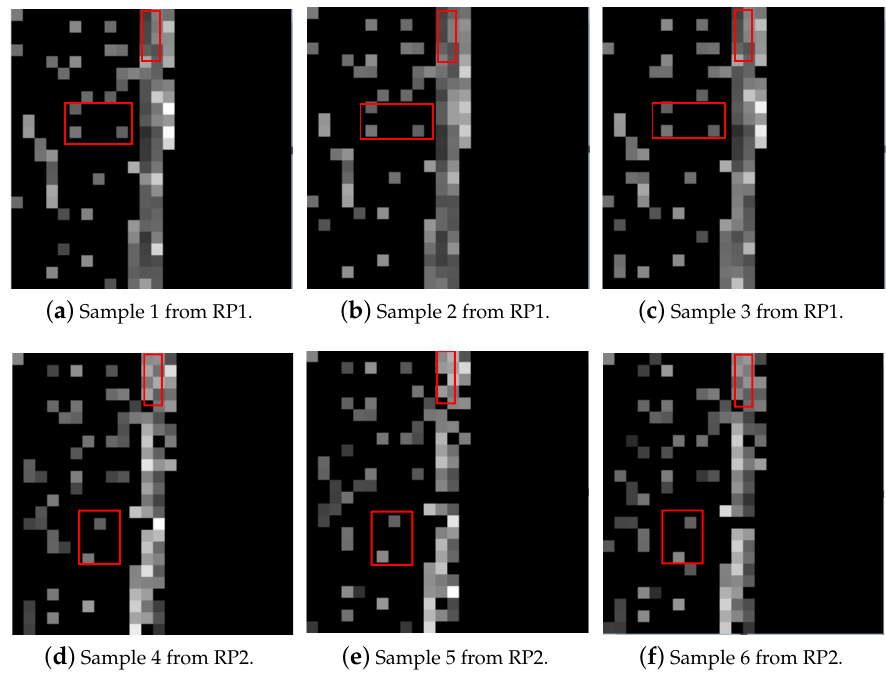
Figure 4. Grayscale images constructed by HW-fingerprint. ( a – c ) from RP1; ( d – f ) from